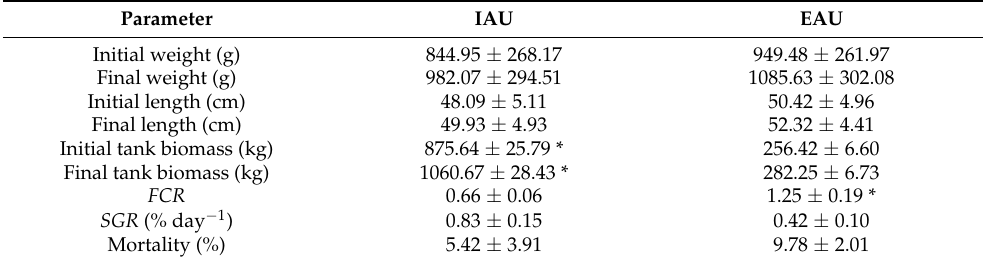
Table 1. Growth performance of African catfish ( C. gariepinus ) under different stocking densities (intensive aquaculture unit (IAU) and extensive aquaculture unit (EAU)) in a semi-coupled aquaponic system with wheatgrass ( T . aestivum ) cultivation (mean ± SD, n = 2).